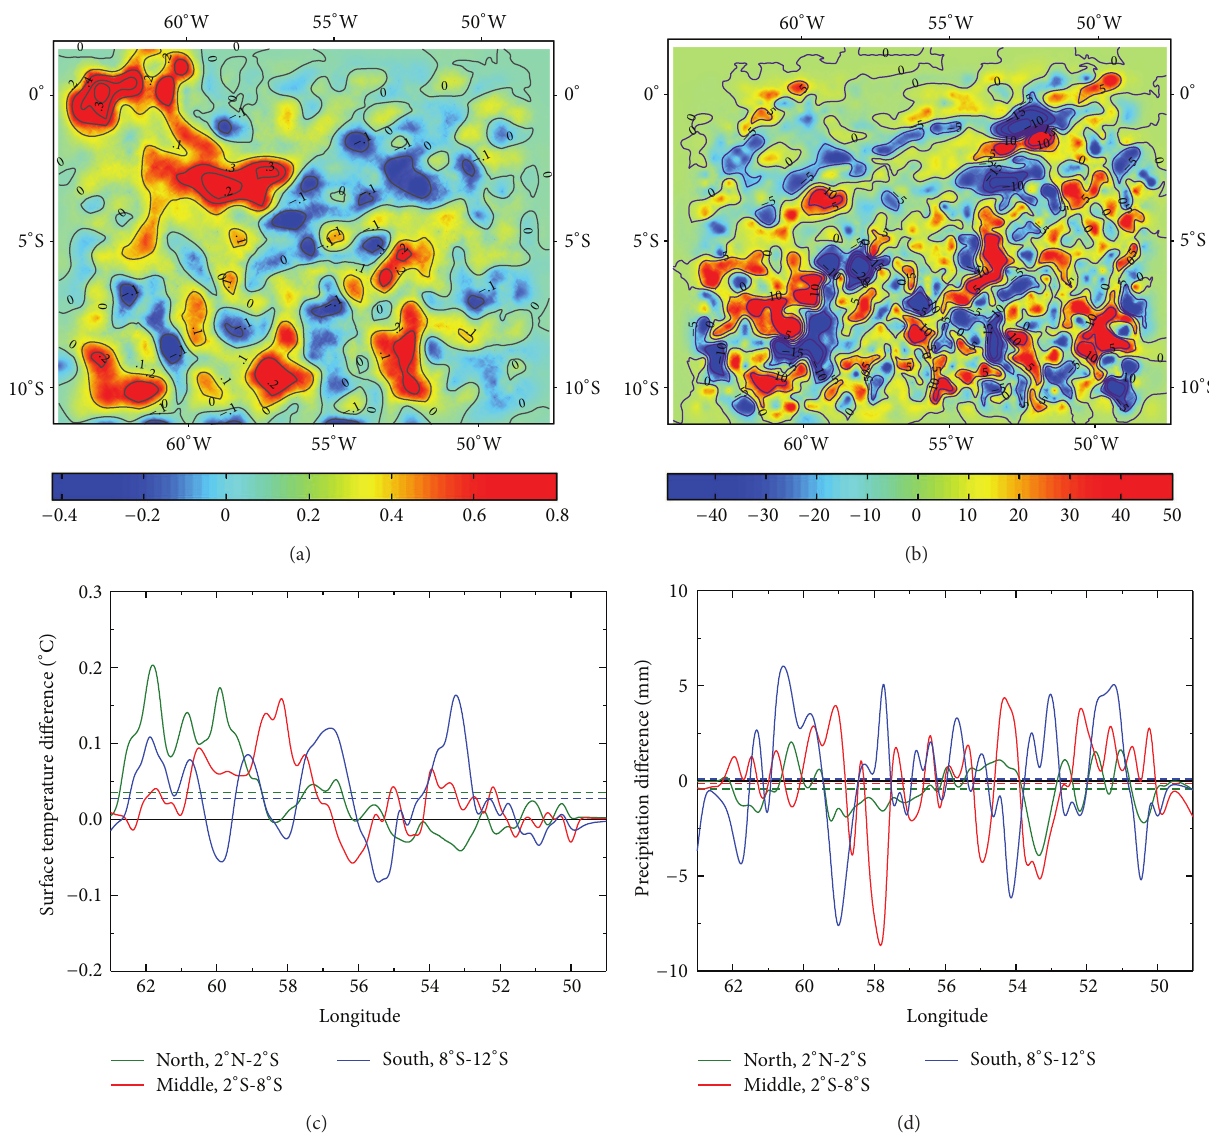
Figure 3: (a) and (b) show the yearly-averaged deviations of surface temperature (a) and precipitation (b) in the year 2100 (deforestation minus control). The surface temperature is contoured at a 0.1 ∘ C interval, and the precipitation is contoured at a 5 mm interval. (c) and (d) are zonally averaged surface temperature (c) and precipitation (d) differences (deforestation minus control). Green line indicates the north region between 2 ∘ N and 2 ∘ S of the Brazilian Amazon, red line is the central region between 2 ∘ S and 8 ∘ S, blue line is the south region between 8 ∘ S and 12 ∘ S, and the dash lines are averages of zonally surface temperature and